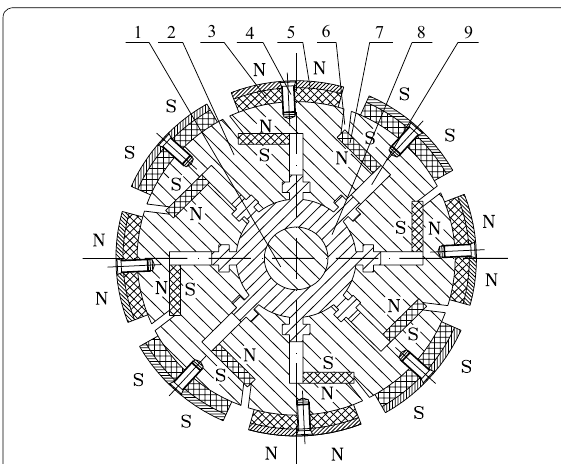
Figure 2 Structure diagram of double-radial permanent magnet rotor. 1: Shaft; 2: Permanent magnet rotor core; 3: Tile-shaped permanent magnet; 4: Non-magnetic screw; 5: Pole boots; 6: Magnetism isolating air gap I; 7: Rectangle permanent magnet; 8: Die-cast aluminum magnetic isolation bushing; 9: Magnetism isolating air gap II